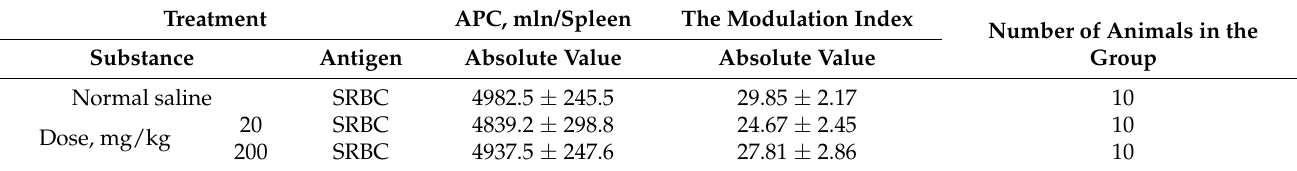
Table 5. Effect of the substance on the accumulation of APC in mice.